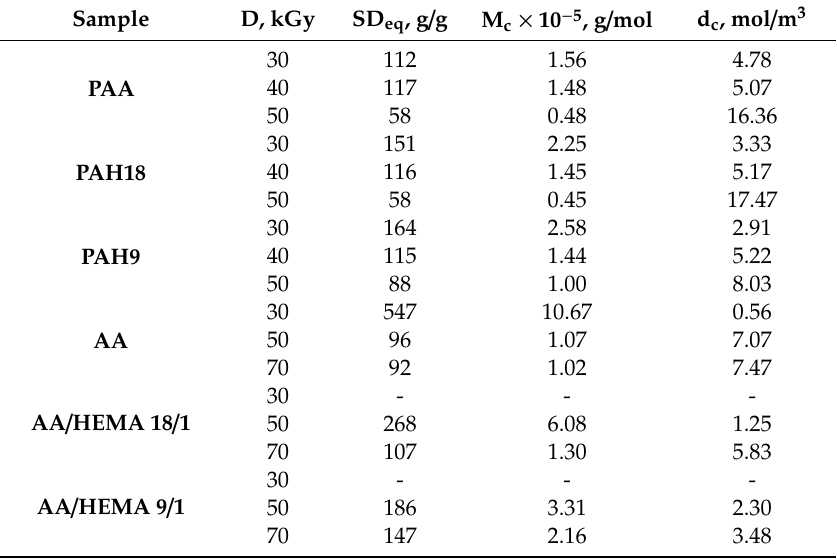
Table 1. E ff ect of absorbed dose on SD eq , M c , and d c .